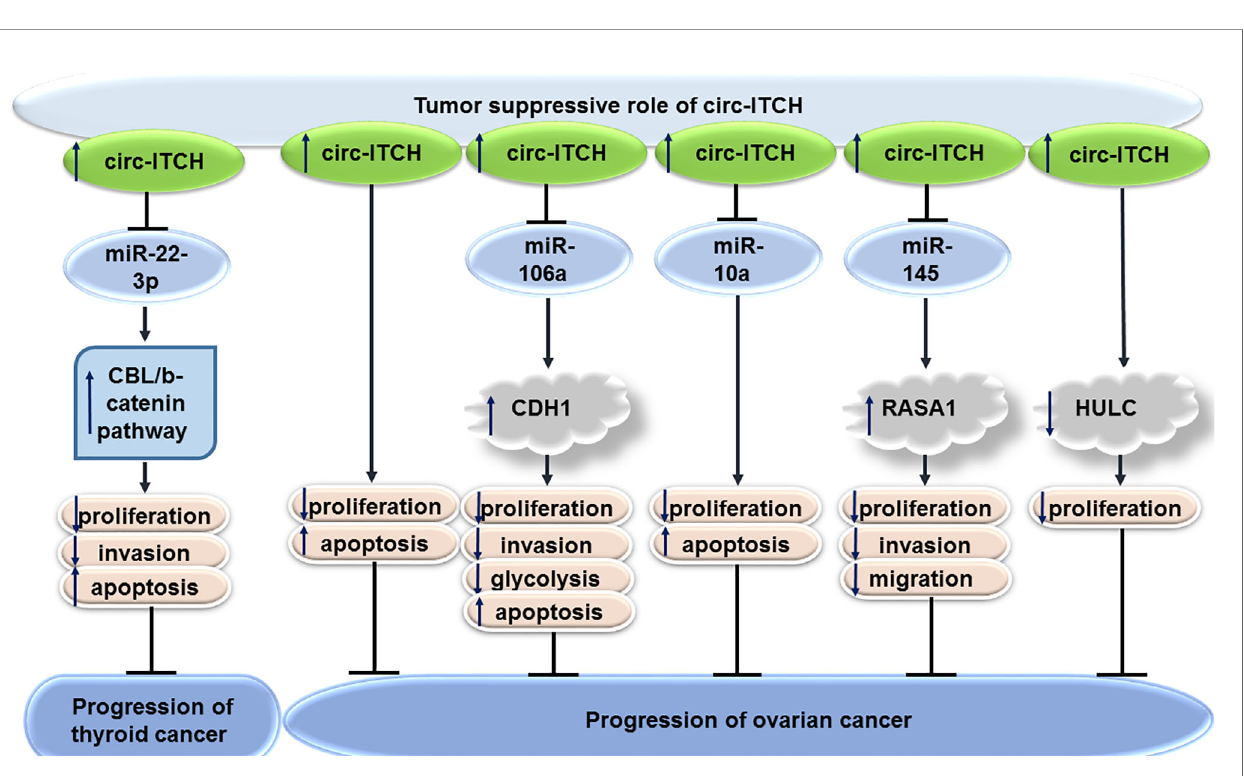
FIGURE 1 | Tumor suppressor role of circITCH in bladder, breast and cervical cancers as well as dual role of this circRNA in osteosarcoma.